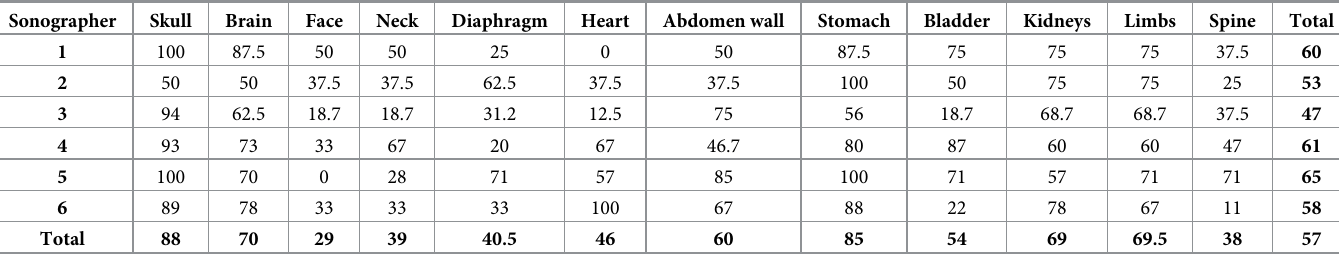
Table 5. Proportion of logbooks with acceptable scores ( > = 70%) per organ system and per sonographer.